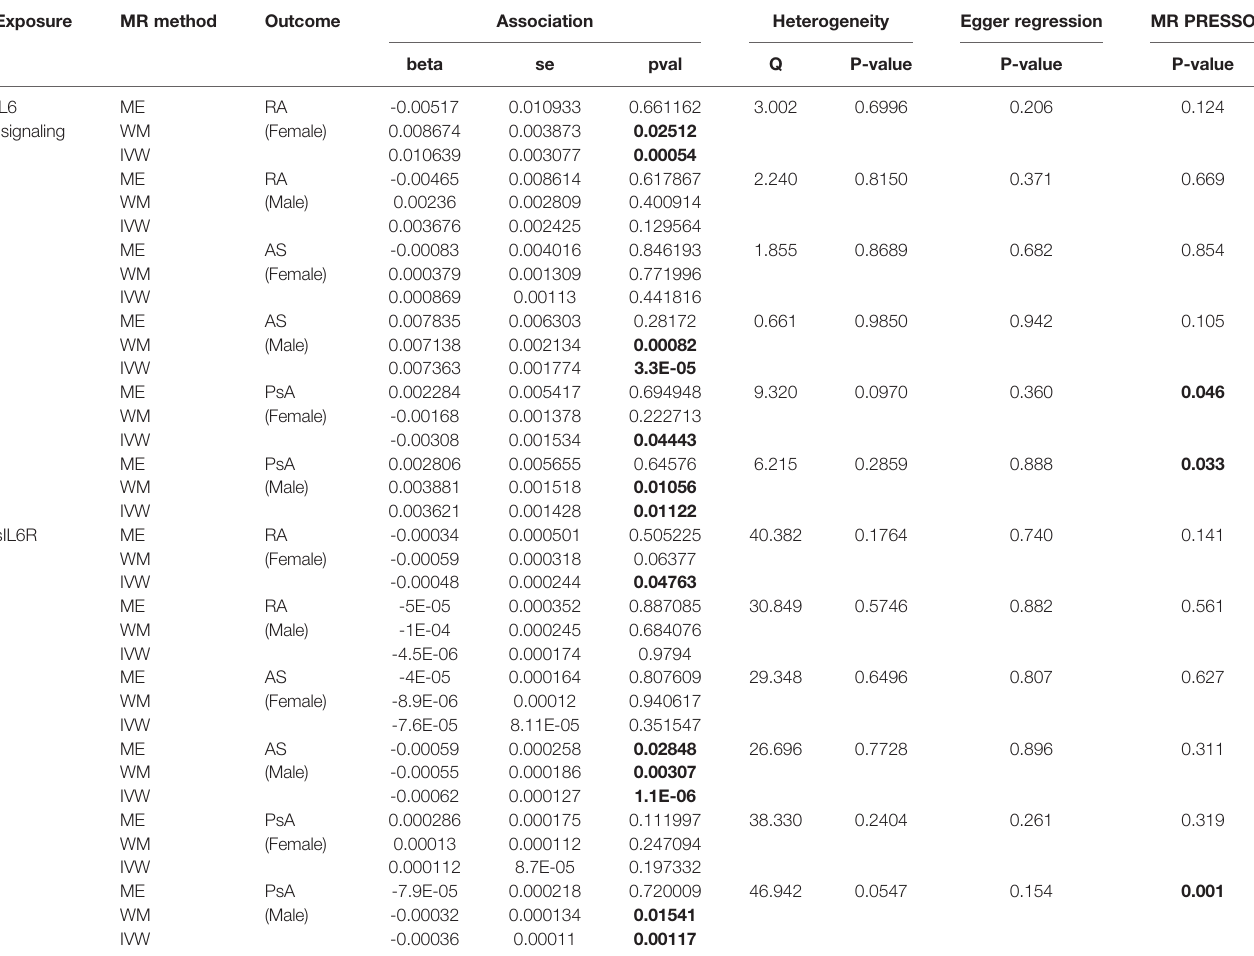
TABLE 2 | Gender-strati fi ed MR estimates of the causal effect of IL6-signaling and sIL6R level on the risk of autoimmune arthritis. Exposure